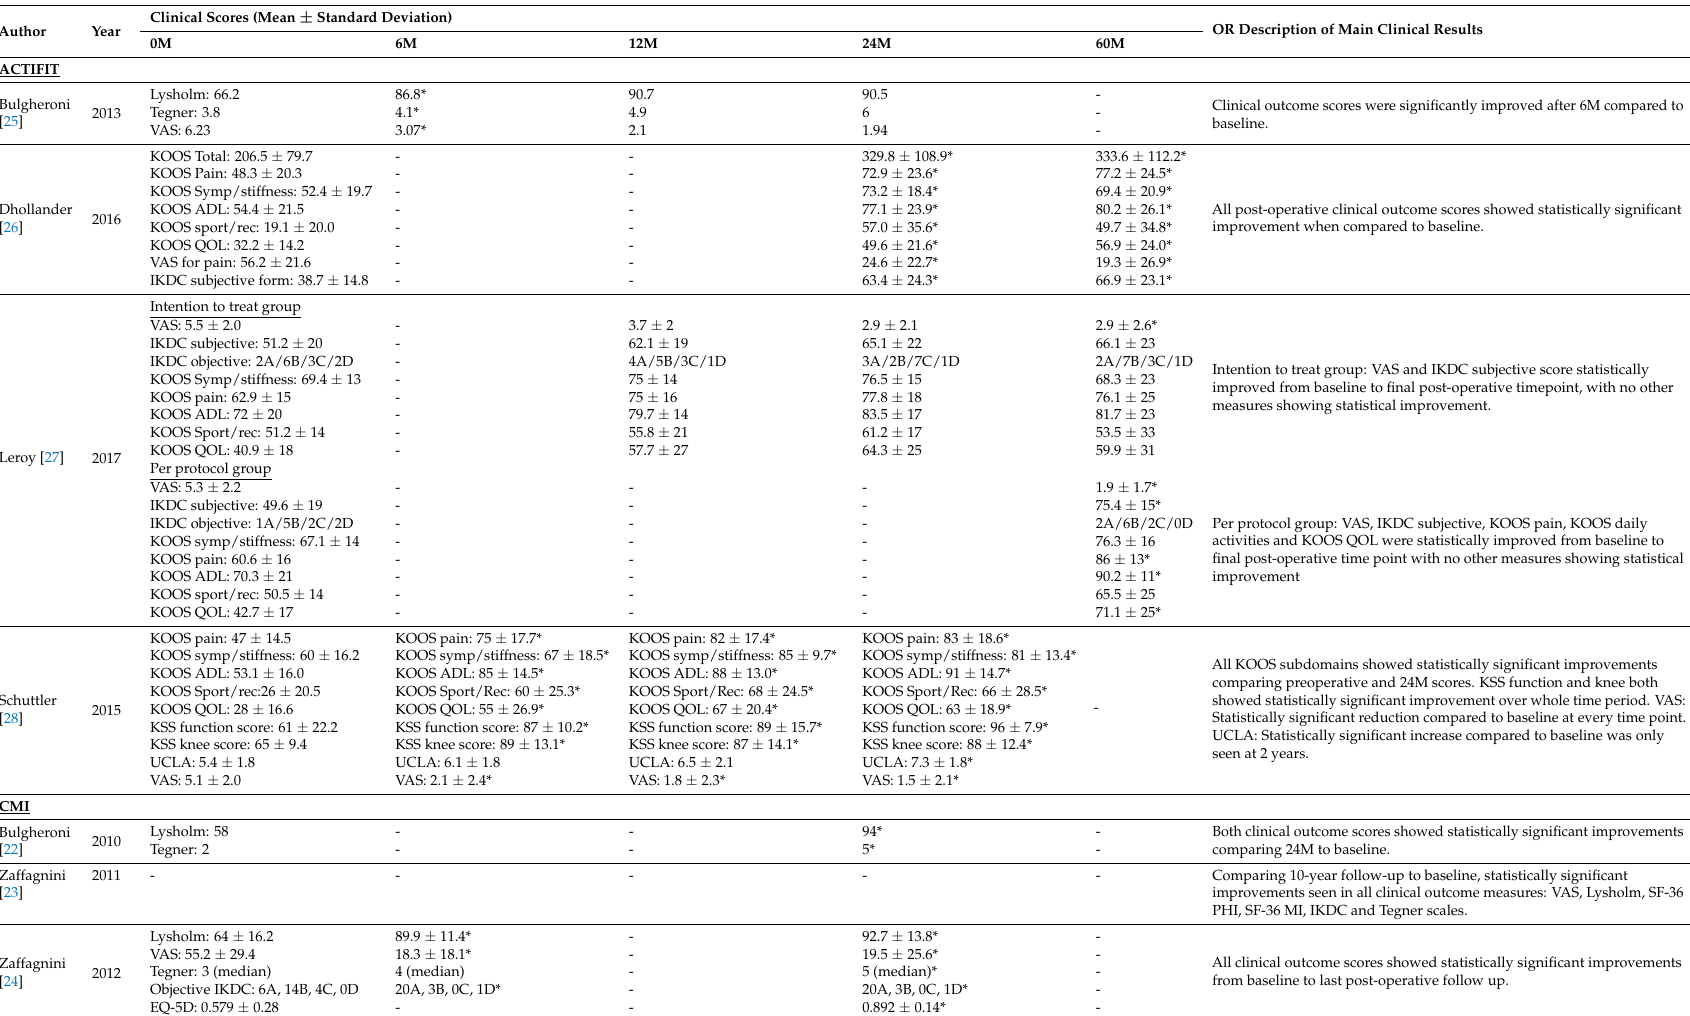
Table 2. The clinical outcome results of each study.